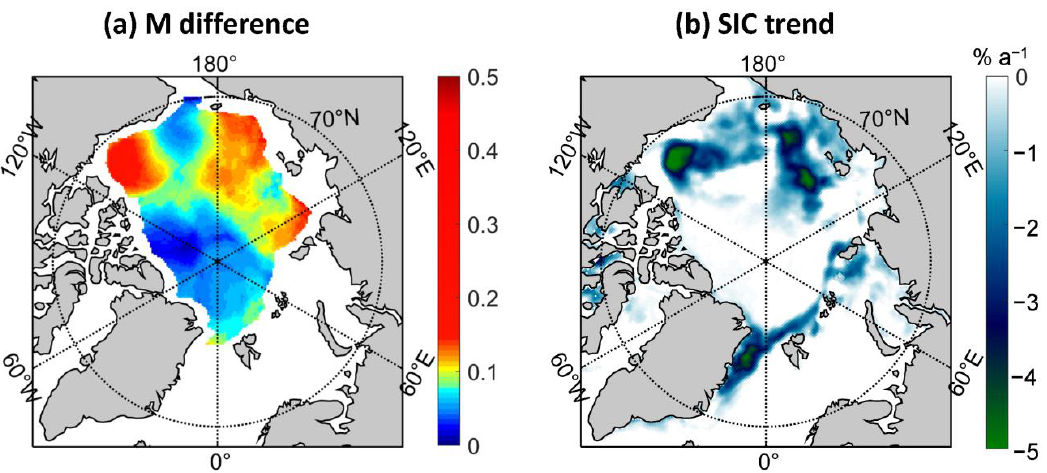
Figure 7. ( a ) Spatial distribution of the 𝑀̅ difference in summer between 2009 – 2019 and 1979 – 2008. ( b ) Spatial distribution of the interannual trend of sea ice concentration (SIC) during 2009 – 2019.